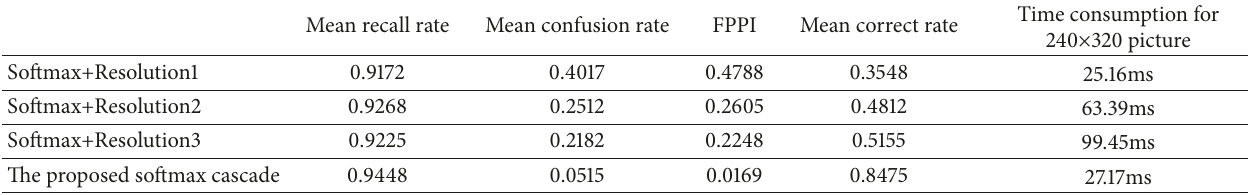
Table 3: Performance comparison between the noncascade (rows 1 to 3) softmax and cascade softmax (row 4) detectors.